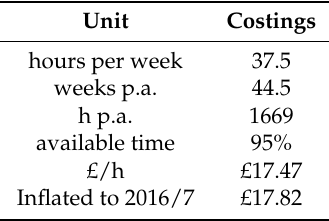
Table A3. Cost per administrator/clerical available hour.